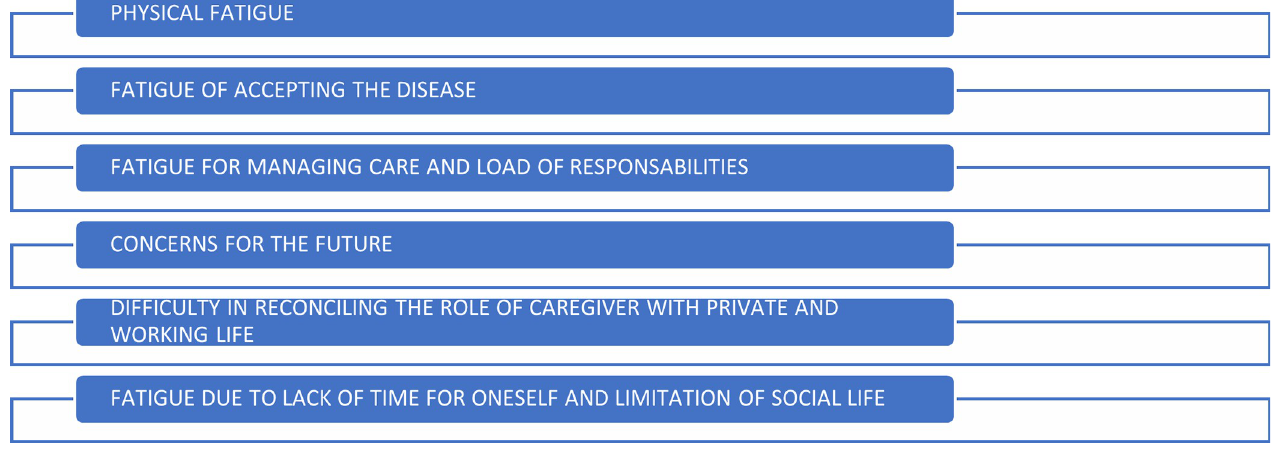
Fig 1. The fatigue of caregivers in